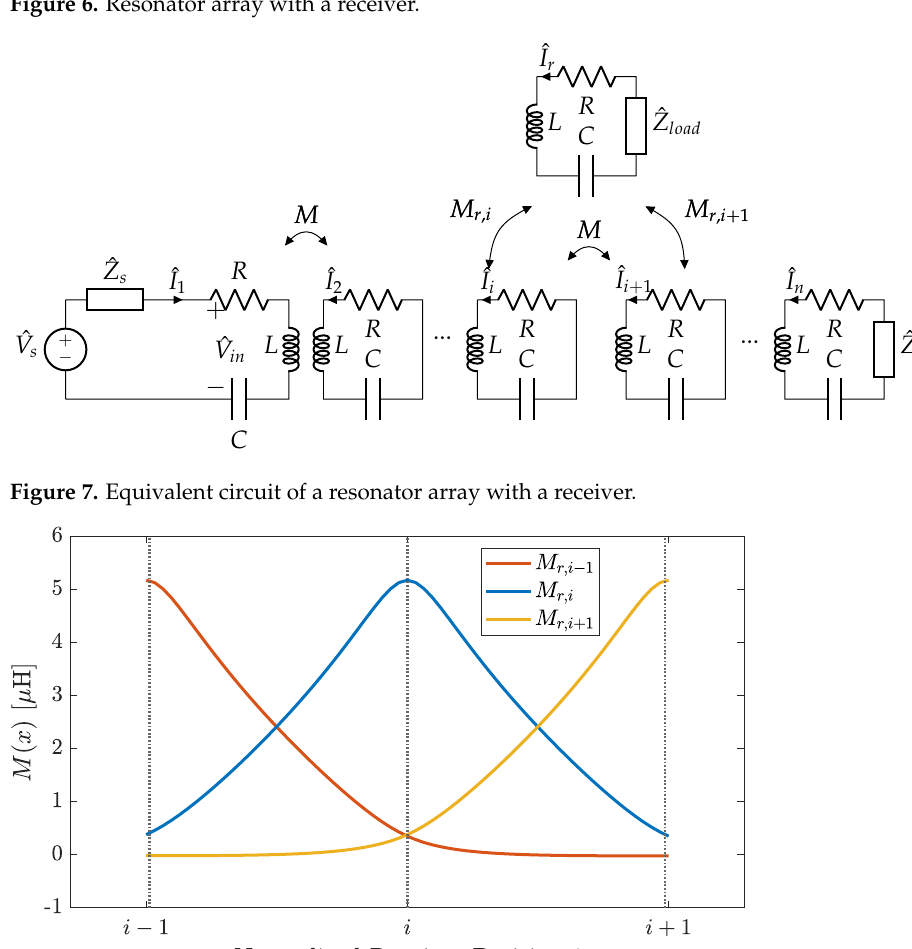
Figure 8. Mutual inductance between the receiver and three consecutive resonators of the array, as a function of the receiver position at a receiver height of 10